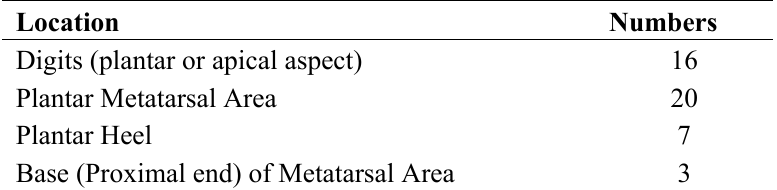
Table 1. Location of primary (treated) lesions.